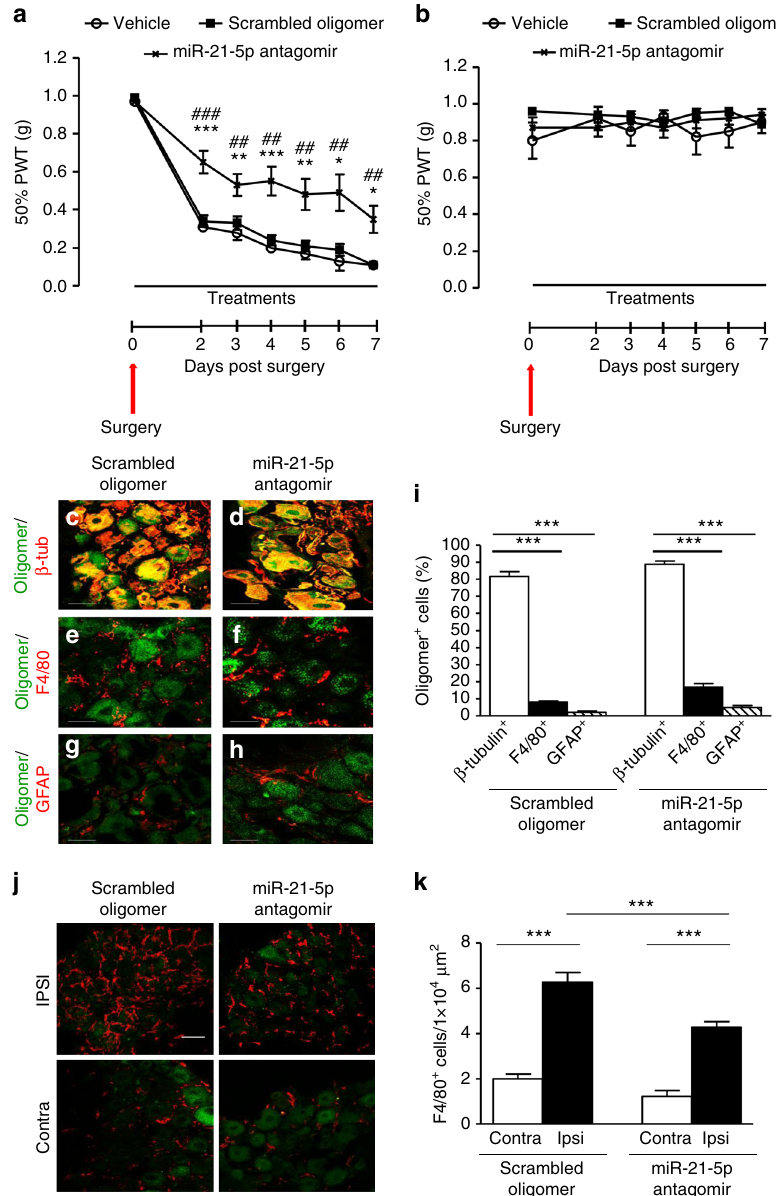
Fig. 8 Intrathecal delivery of miR-21 antagomir prevents mechanical hypersensitivity and reduces macrophage numbers in the DRG following SNI injury. a Effect of continuous intrathecal delivery of the miR-21-5p antagomir (12 pmol/day) for 7 days on the development of mechanical hypersensitivity. b No effect on contralateral nociceptive thresholds of miR-21-5p, scrambled oligomers, or vehicle. Data are presented as 50% of paw withdrawal thresholds (PWT); means ± S.E.M., n = 6 mice in vehicle group and 12 mice in oligomer-treated groups. * P < 0.05, ** P < 0.01, *** P < 0.001 compared to vehicle; ## P < 0.01, ### P < 0.001 compared to scrambled oligomer, two-way ANOVA followed by Tukey test. Scrambled oligomer and miR-21-5p antagomir (green) distribution in L5 DRG and co-localization with the neuronal marker β -tubulin (red; c , d , i ) macrophage marker F4/80 (red; e , f , i ), or the satellite cell marker GFAP (red; g – i ). Scale bar = 50 μ m. j Macrophage in fi ltration (F4/80, red) in ipsilateral and contralateral L5 DRG. Scale bar = 50 μ m. k Quanti fi cation of F4/80 + cells in L4 and L5 DRG ipsilateral and contralateral to injury following intrathecal delivery of either the scrambled oligomer or miR-21-5p antagomir. Data are means ± S.E.M., n = 4 for each group. *** P < 0.001, one-way ANOVA, post hoc Bonferroni